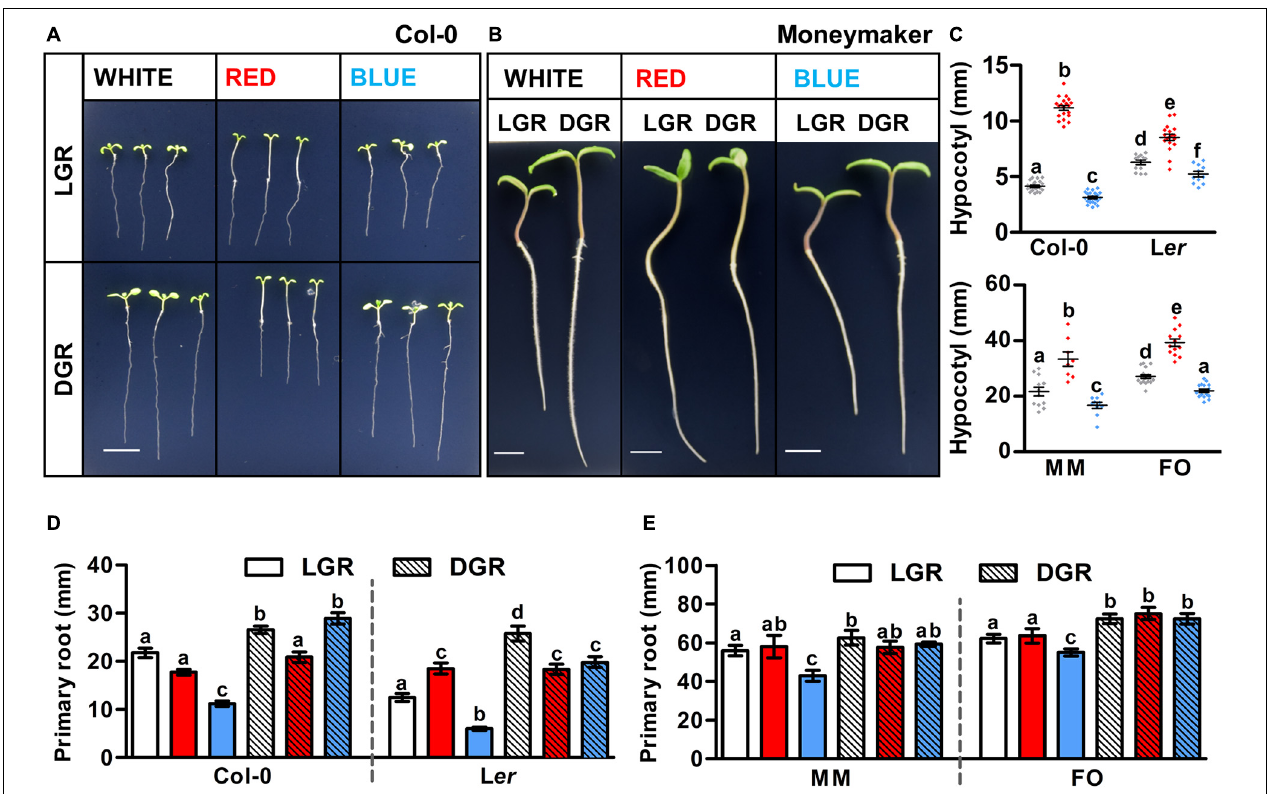
FIGURE 1 | The effect of red and blue light on primary growth of Arabidopsis and tomato seedlings. (A,B) Representative 7 day old Arabidopsis and 5 day old tomato seedlings grown in white, red, or blue LED conditions. Seedlings of Arabidopsis ecotype Columbia (Col-0) (A) and tomato cultivar Moneymaker (MM) (B) were grown in light-grown roots (LGR) and dark-grown roots (DGR) LED conditions. For presentation purposes, seedlings were transferred to black agarose plates before photographing. Scale bars indicate 1 cm. (C–E) Quantification of the hypocotyl length of DGR seedlings (C) and the primary root length of LGR and DGR seedlings (D,E) of Arabidopsis ecotypes Col-0 and Landsberg erecta (L er ) and tomato cultivars MM and Foundation (FO) as shown in ( A,B , and Supplementary Figures S4A , S5A ), respectively. LED conditions and ecotypes or cultivars were compared using a one-way ANOVA followed by a Tukey’s test (letters a–f indicate statistically significant differences values, p < 0.05) in (C–E) . Error bars represent standard error of the mean in (C–E) ( n = 30). Similar results were obtained in three independent